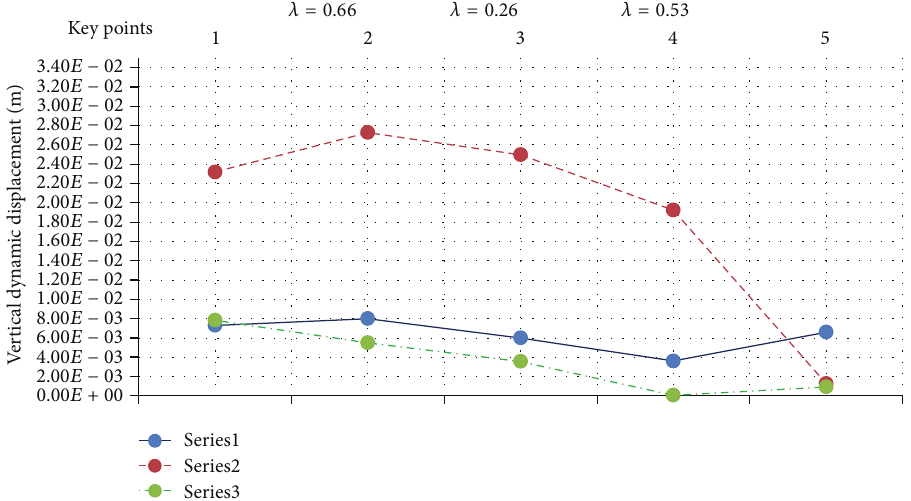
Figure 9: Vertical dynamic displacement at the end of earthquake for models, horizontal and vertical axis show key points and vertical displacement (meter),